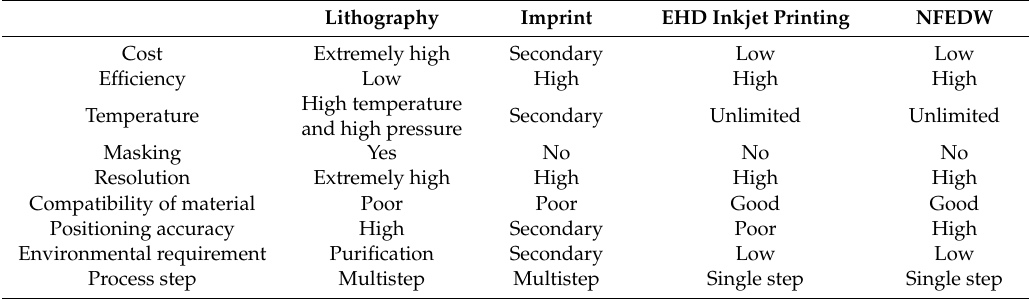
Table 1. Comparison of the main micro-patterning techniques. EHD—electrohydrodynamic; NFEDW— near-field EHD